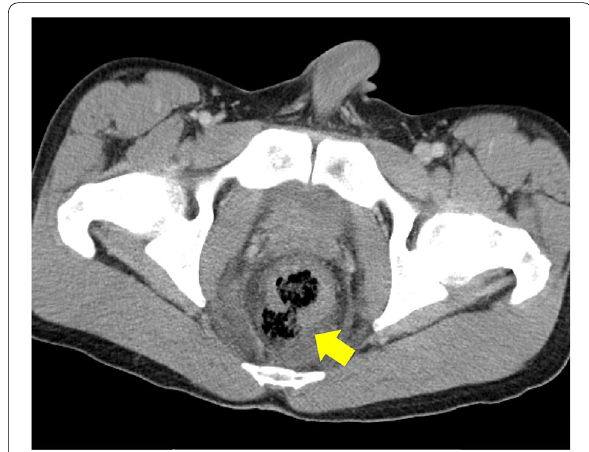
Fig. 2 Abdominal CT scan revealed full-layer perforation in the posterior rectal wall and leakage of feces into the extraperitoneal space (yellow arrow)